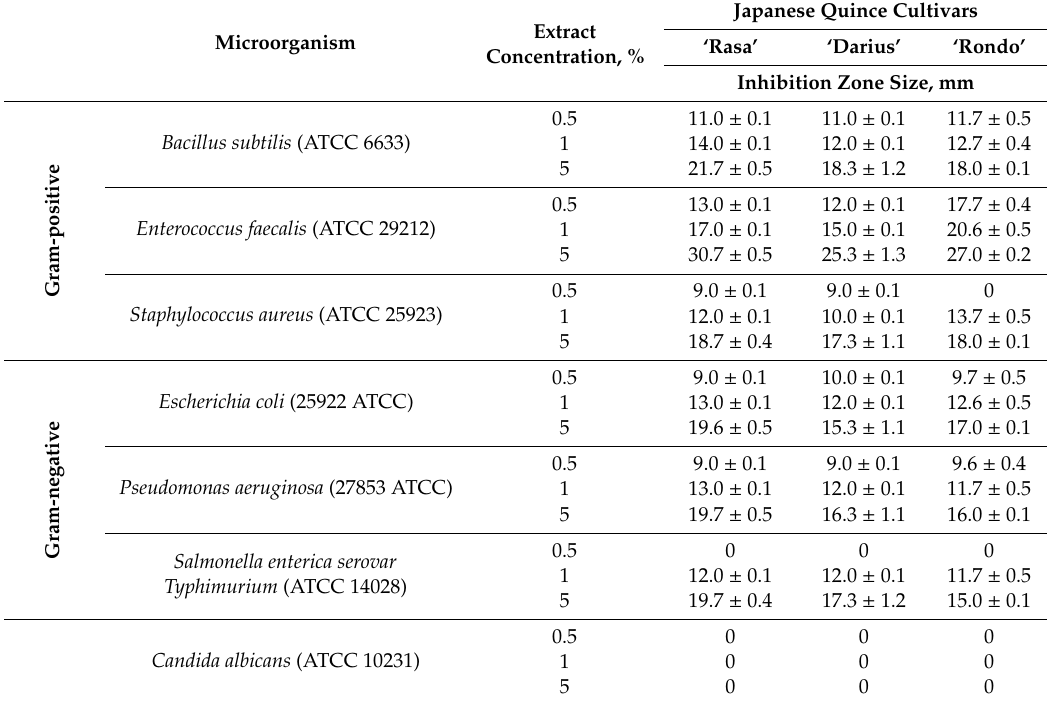
Table 6. Antibacterial activity of Japanese quince fruit